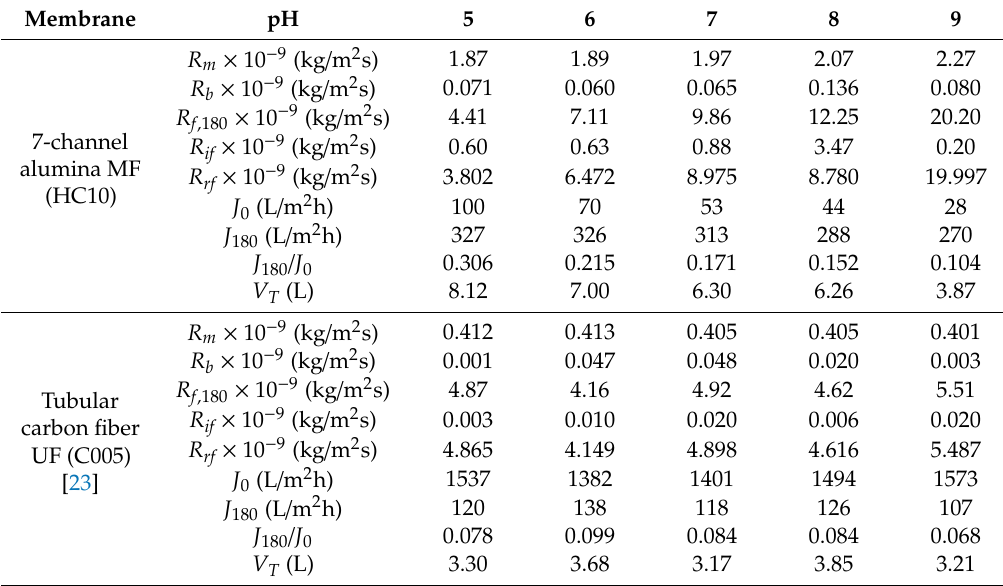
Table 8. E ff ect of pH on filtration factors in the hybrid process of 7-channel alumina MF (HC10) membrane and PP beads with periodic water backwashing (BT 10 s, FT 10 min) as compared with results of tubular carbon fiber UF (C005)